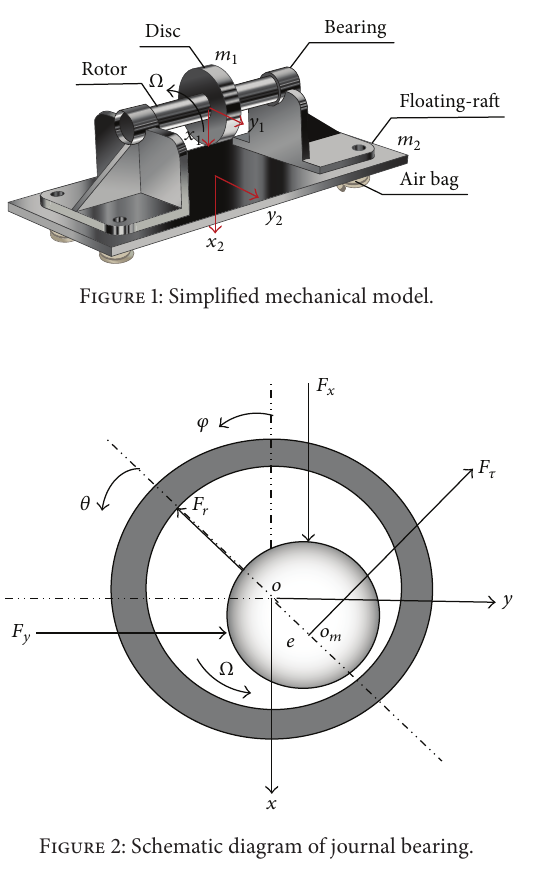
Figure 2: Schematic diagram of journal bearing.